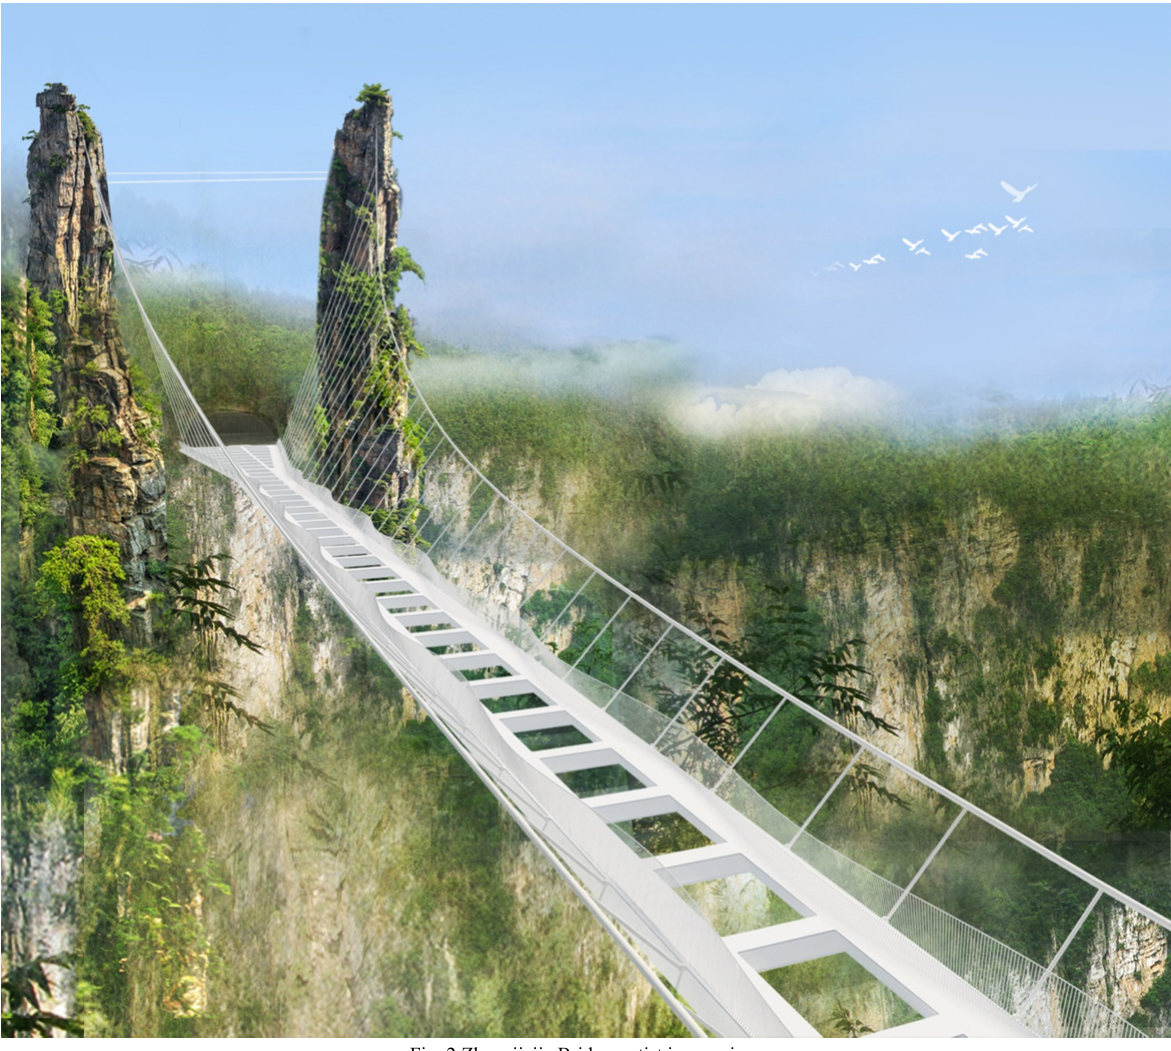
Fig. 2 Zhangjiajie Bridge; artist